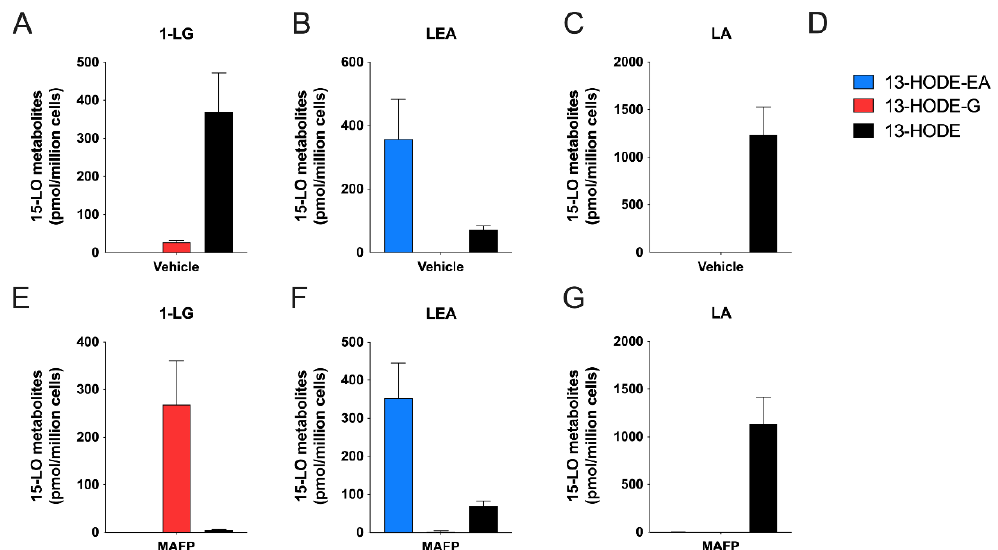
Figure 4. Metabolism of LA, 1-LG or LEA by human eosinophils. Pre-warmed human eosinophil suspensions (37 °C, 10 6 cells/mL in HBSS containing 1.6 mM CaCl 2 ) were treated with DMSO ( A – C ) or MAFP 1 µM ( E – G ) for 5 min then stimu- lated with 3 µM of ( A , E ) 1-LG, ( B , F ) LEA, ( C , G ) LA for another 5 min. ( D ) Metabolite legend for panels. ( A – G ) Incubations were stopped by the addition of one volume of cold ( − 20 °C) MeOH containing the internal standards. Samples then were processed for LC-MS analysis as described in methods. Results are the mean (±SEM) of 4–5 independent experiments.